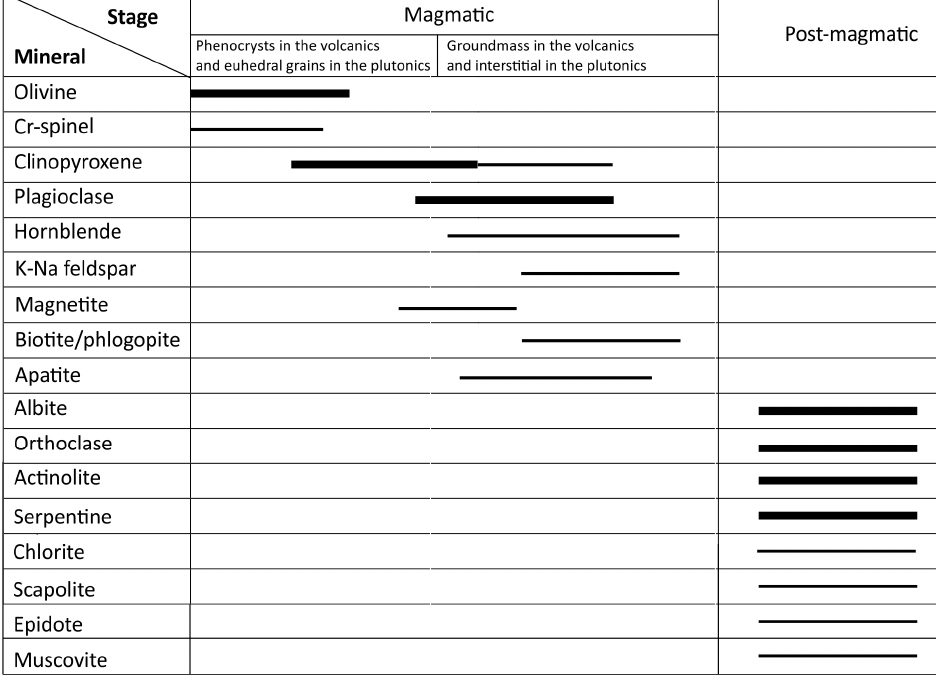
Figure 16. Crystallization sequence for the studied complex. Heavy lines refer to the rock-forming minerals (and abundant crystallization), and light lines refer to the minor and accessory minerals (and minor crystallization).